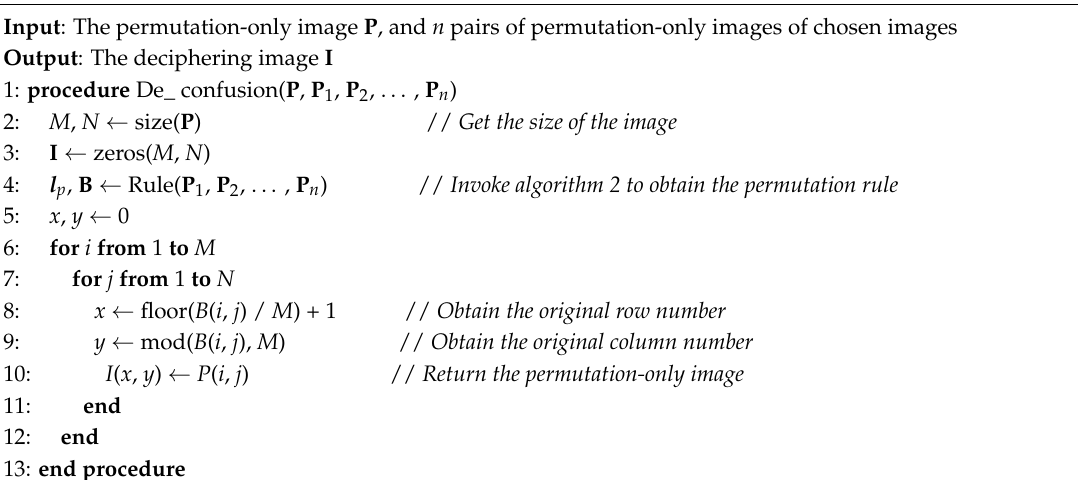
Algorithm 4 Proposed confusion attack